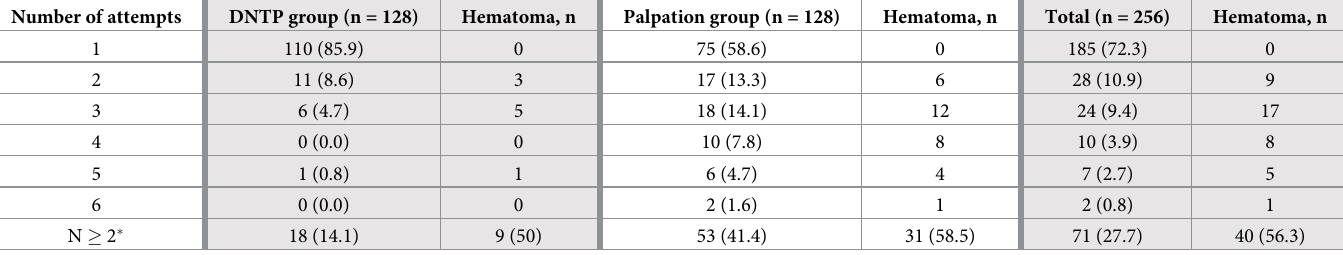
Table 4. Exploratory analysis of number of attempts and incidence of